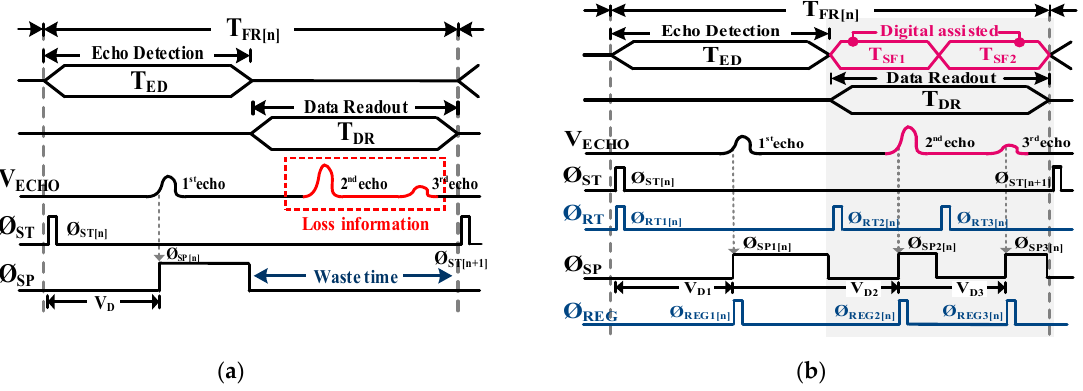
Figure 2. ( a ) conventional readout scheme and ( b ) proposed readout scheme in a focal plane array (FPA)-based LADAR.